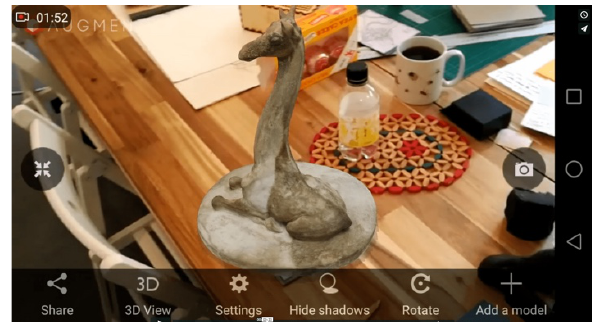
Figure 10: Image of the representation of a 3d model in the space in scale 1:1. Through an app it is possible to locate the object anywhere in the view range of the phone camera